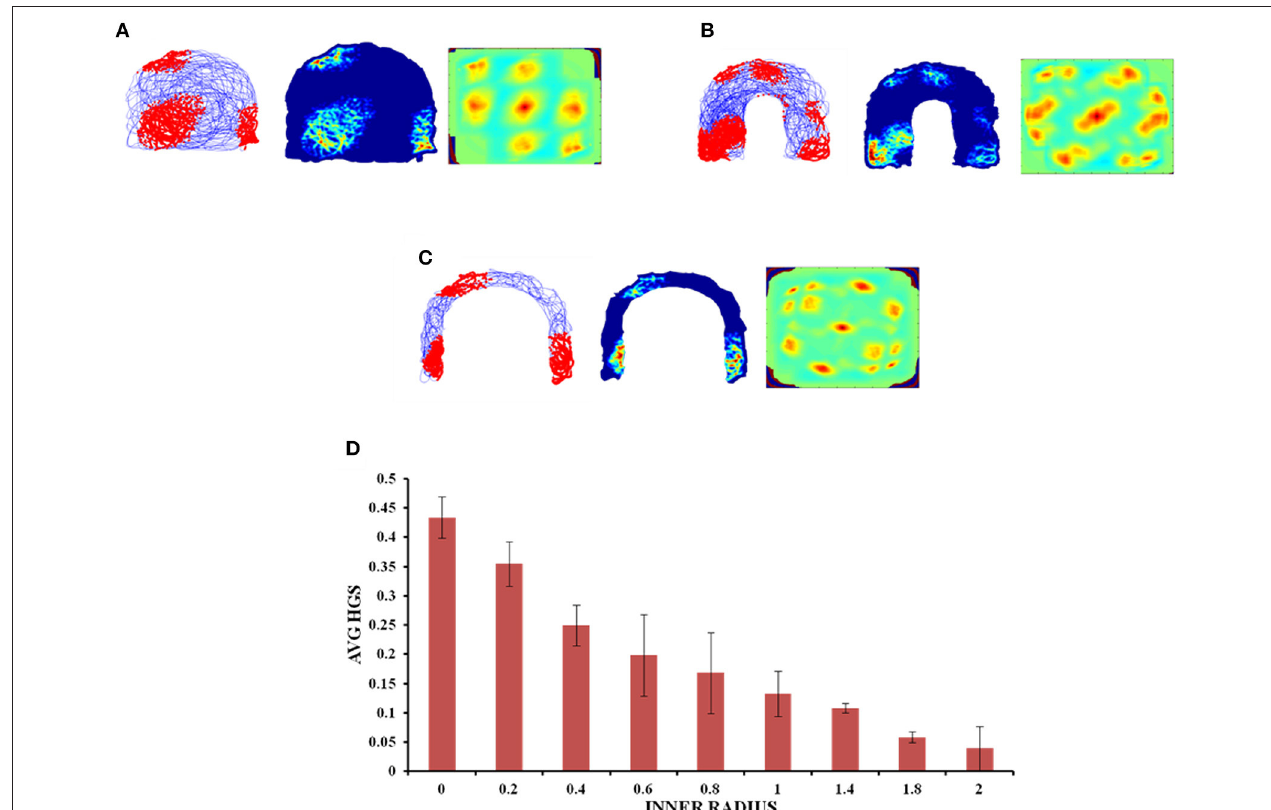
FIGURE 6 | Grid cell responses in horseshoe shaped environment. (A–C) Firing field, firing rate, and auto correlation maps of horseshoe boundary with varying inner radii of 0, 0.8, and 2, respectively. (D) Average HGS values vs. inner radii of horseshoe shaped